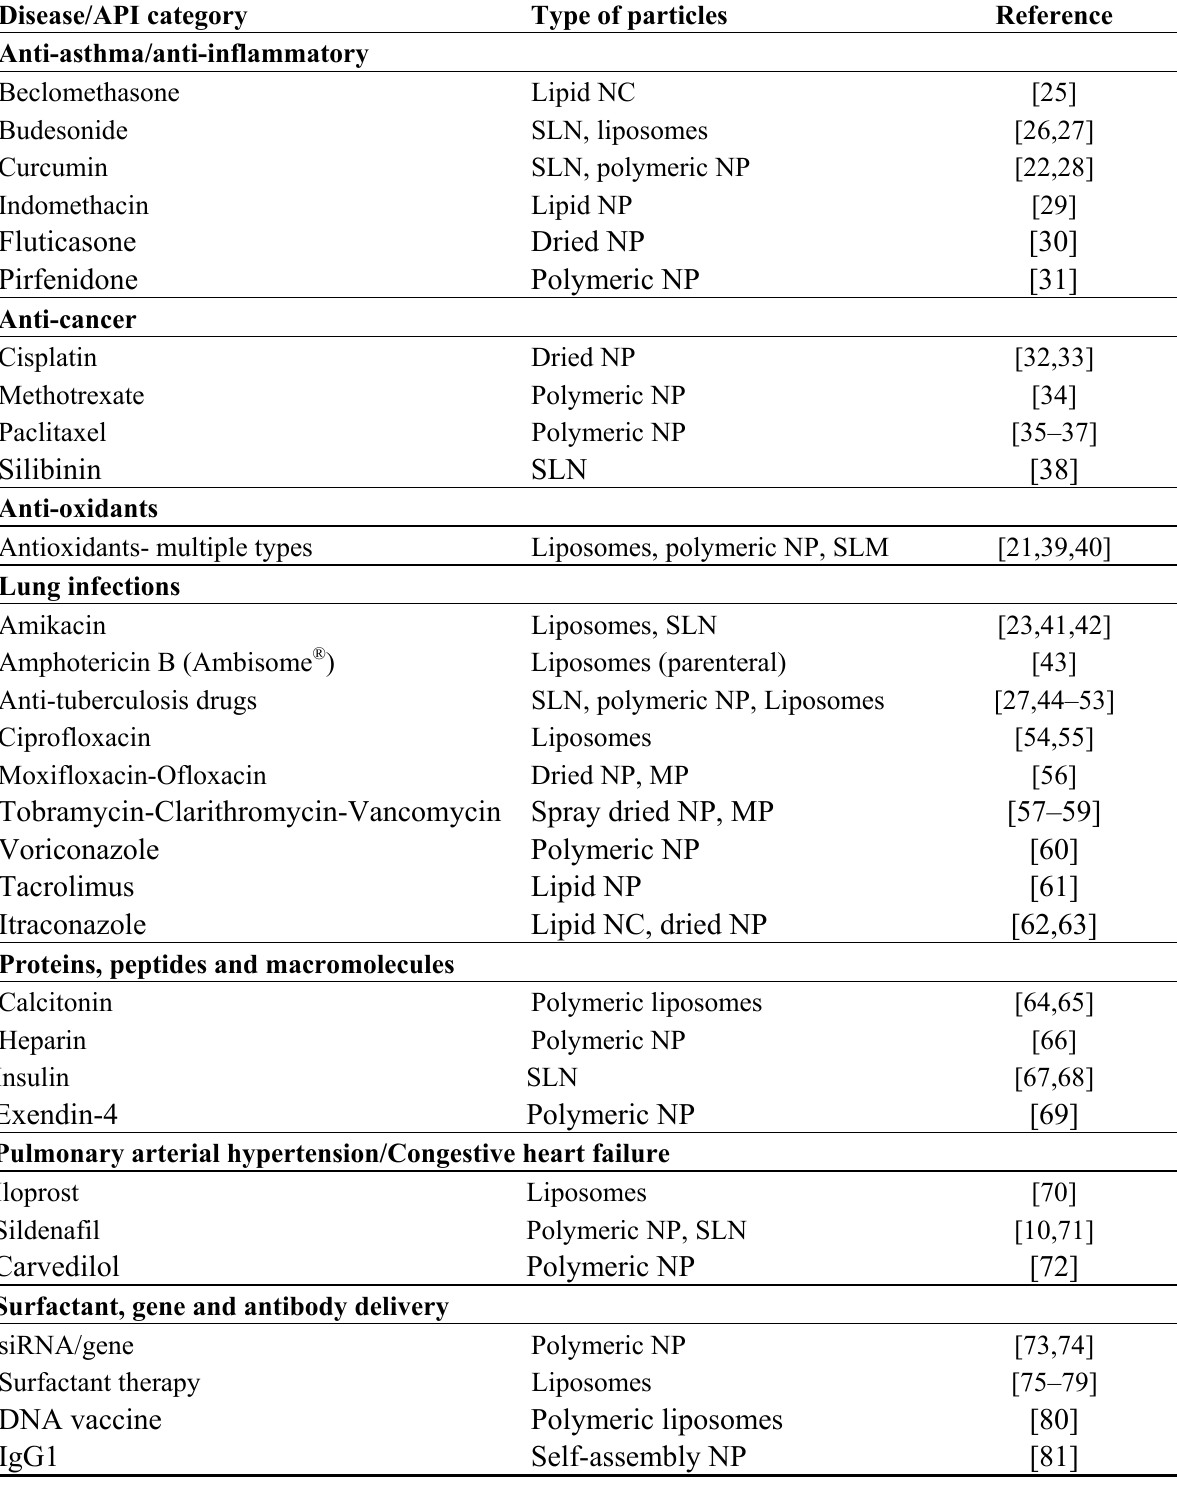
Table 2. Different active pharmaceutical ingredient (API) molecules incorporated into different nanoparticle systems for pulmonary application. SLN, solid lipid nanoparticles; SLM, solid lipid microparticles; NP, nanoparticles; NC,